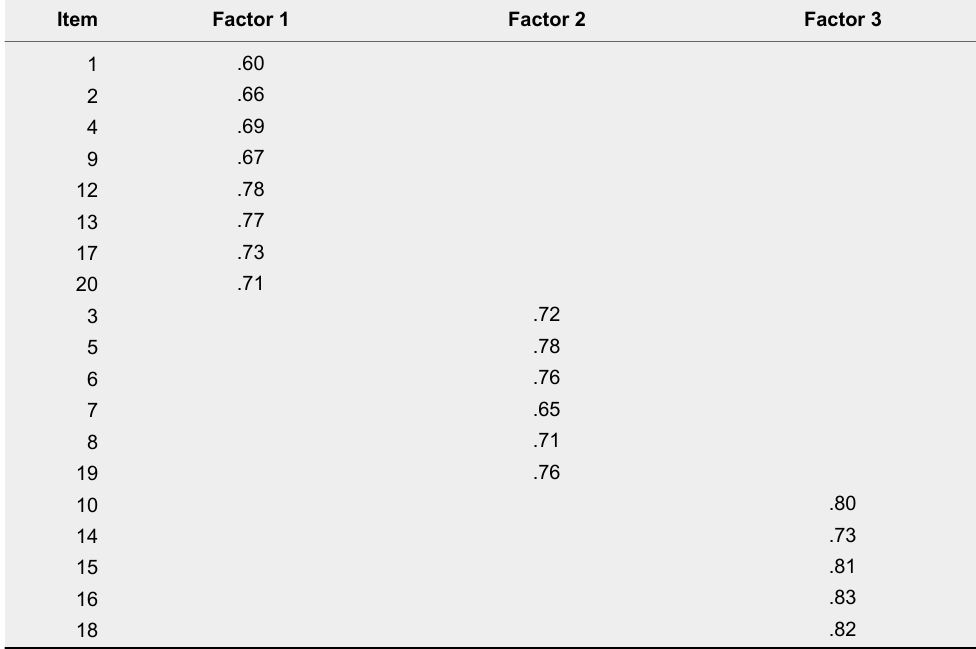
Factor Loadings of the Confirmatory Factor Analysis (CFA) of the Three-Factor Solution of the CES Item Factor 1 Factor